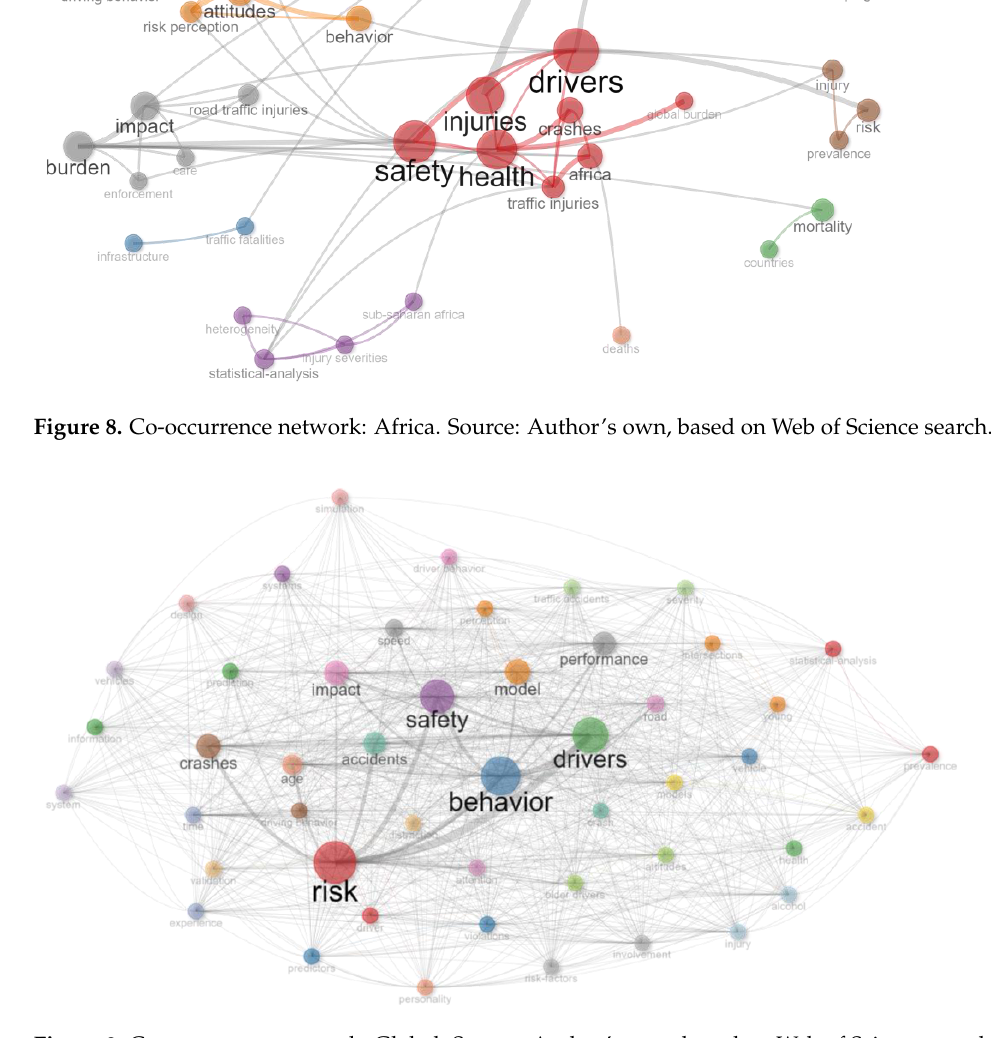
Figure 9. Co-occurrence network: Global . Source: Author’s own, based on Web of Science search .